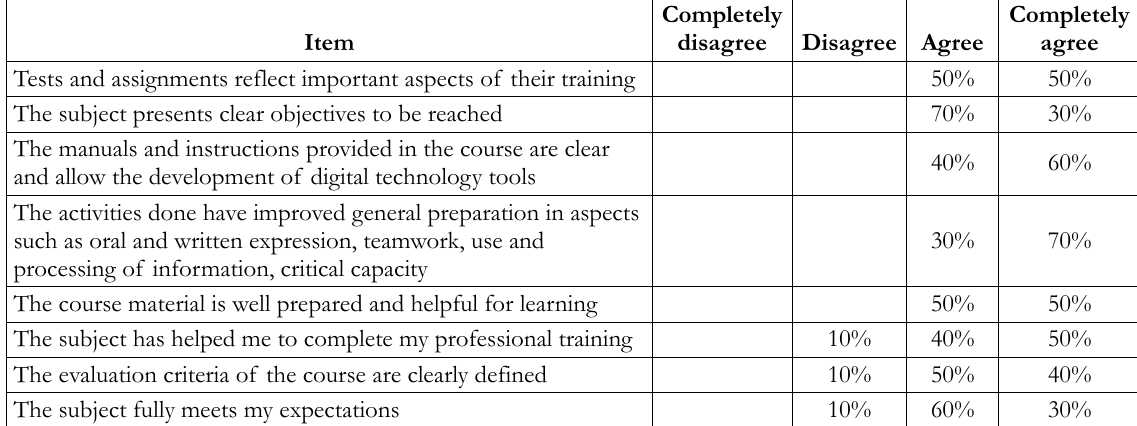
Table 2. Survey related to the subject